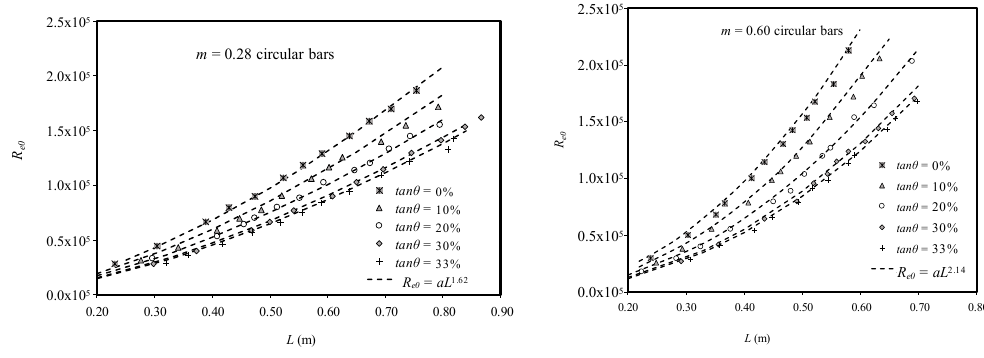
Figure 15. Reynolds number at the beginning of the rack R e 0 as a function of the wetted rack length L , for circular bars with void ratio m = 0.28 and 0.60.